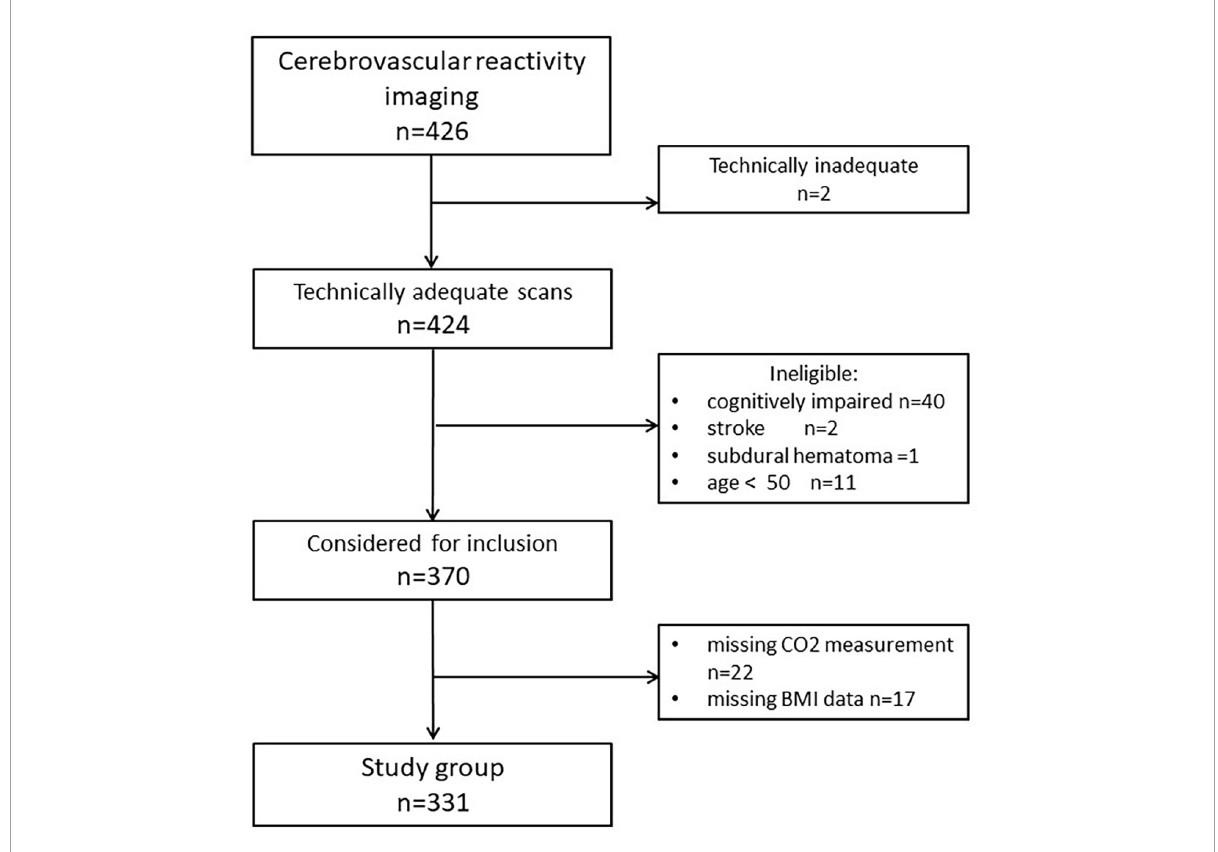
FIGURE1 A flowchart describing the final study